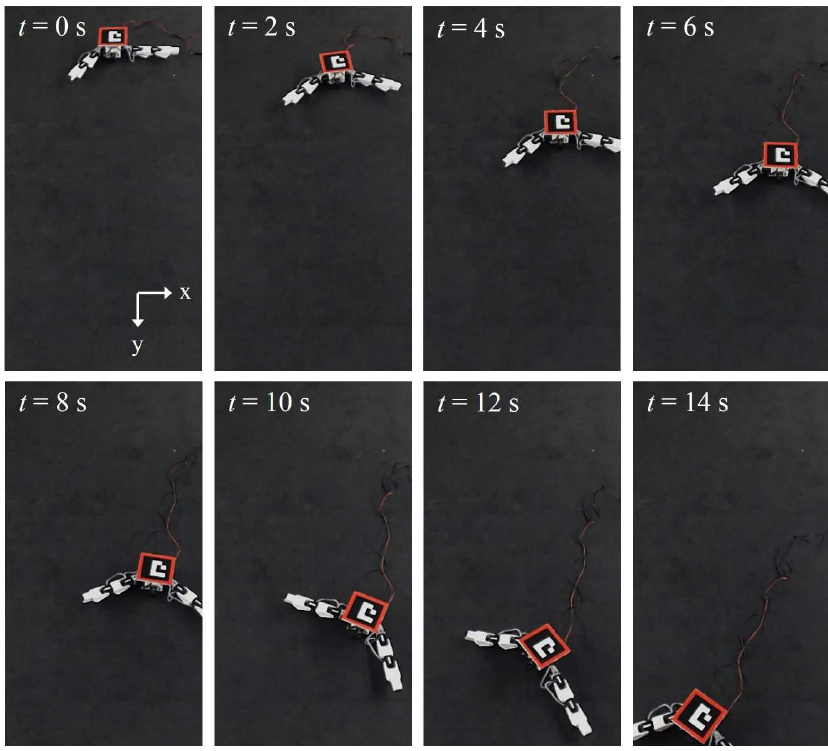
Figure 21. CIQR with two diagonal legs performing recovery action after learning with the SLMIC